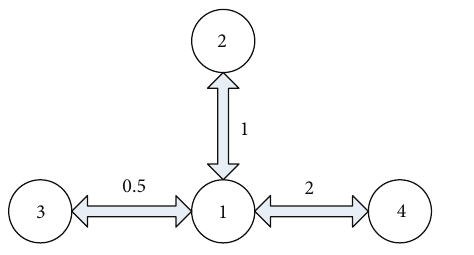
Figure1:Undirectedcommunicationgraph 𝐺 usedforfourth-order consensus problem.